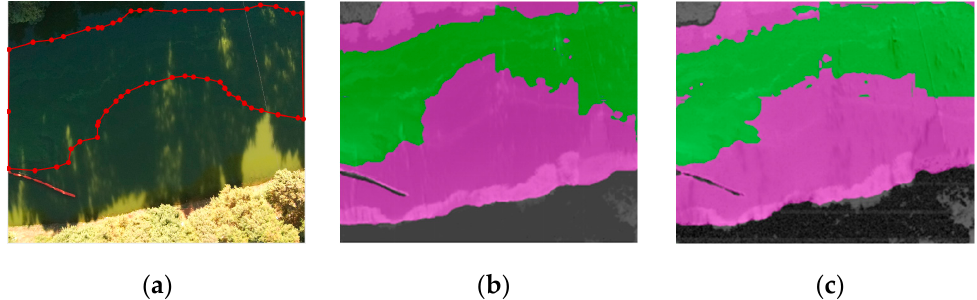
Figure 5. Detection results of different algorithms for reflection scene: ( a ) visible light image; ( b ) detection results of NDVI as the feature-extraction method; ( c ) detection results of NDVI sqrt as the feature-extraction method.